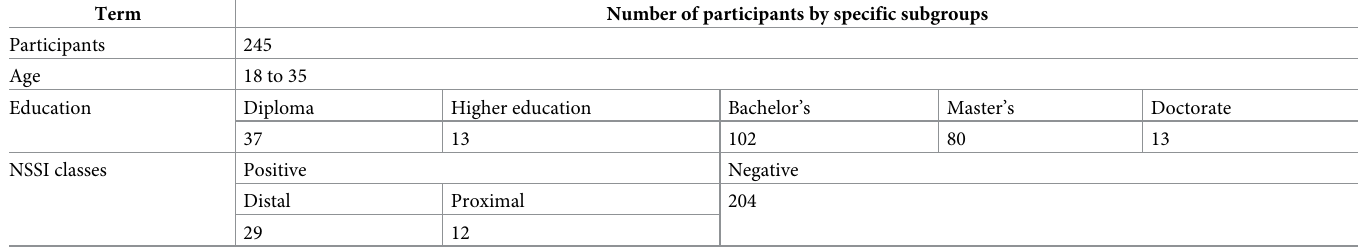
Table 1. Participants’ information regarding age, education, and NSSI behaviors.